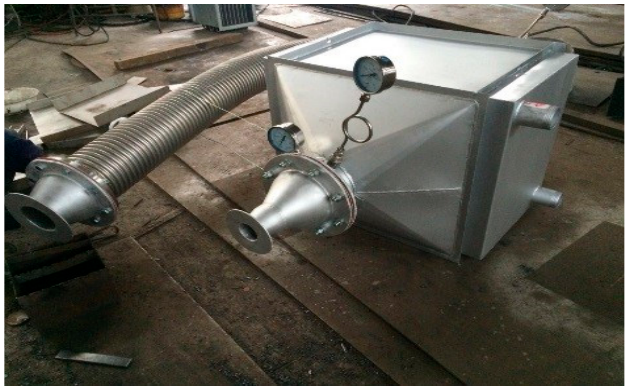
Figure 3. Exhaust gas cooler.